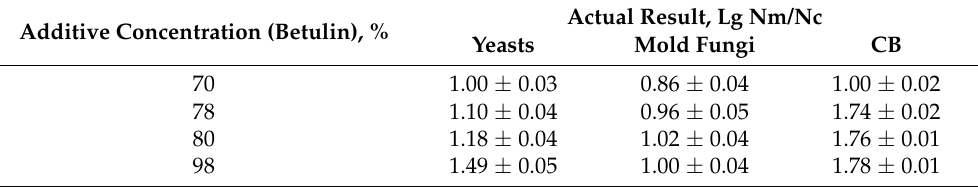
Table 5. Efficiency of films disinfection with different content of betulin in relation to yeasts, mold fungi, and